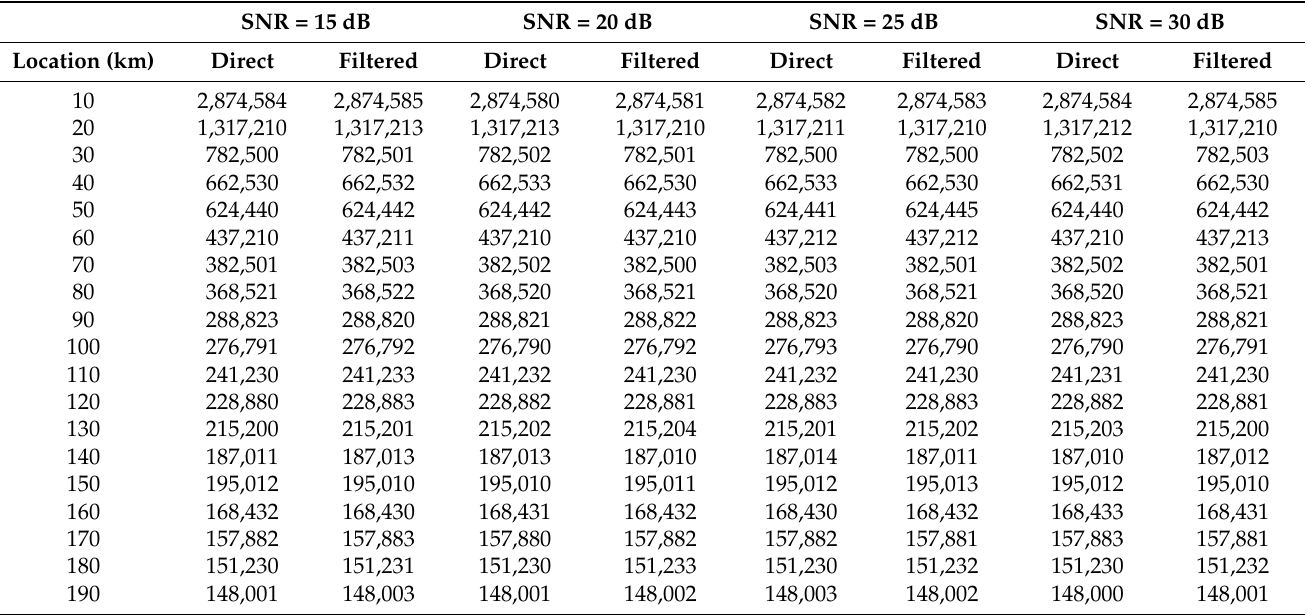
Table A2. Max singular value of FRFT-SVD results at various SNRs for direct and filtered signals under LL-G fault scenario.